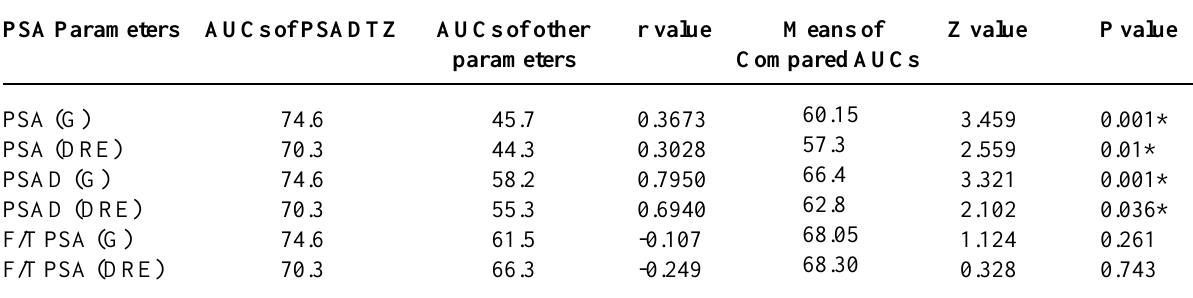
Table 5 – Comparative analysis of areas under the curves (AUCs) of PSA density in the transition zone with areas AUCs of the other parameters in the general and negative digital rectal examination